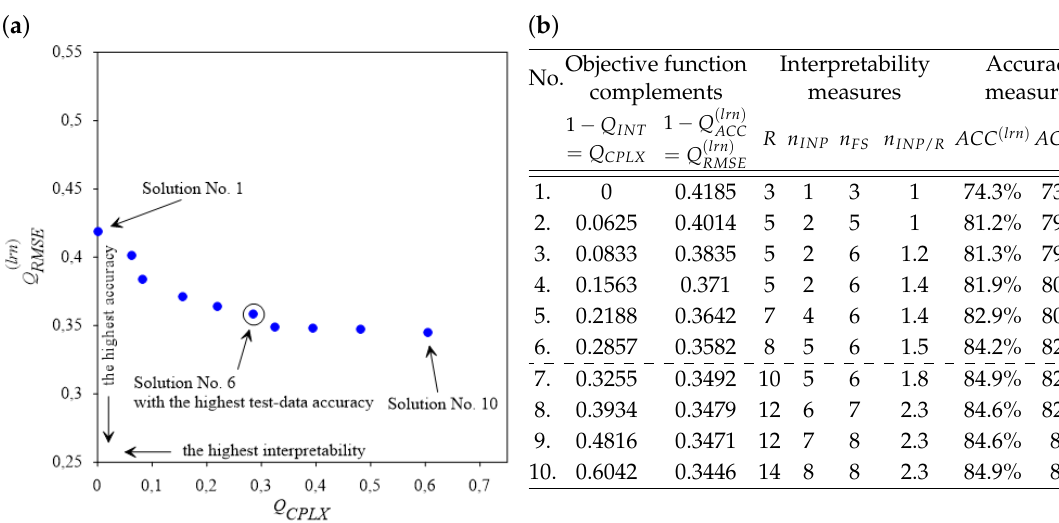
Figure 5. ( a ) The best Pareto-front approximation generated by our SPEA3; ( b ) interpretability and accuracy measures of solutions from ( a ) ( Concise Simulated Data Set ).